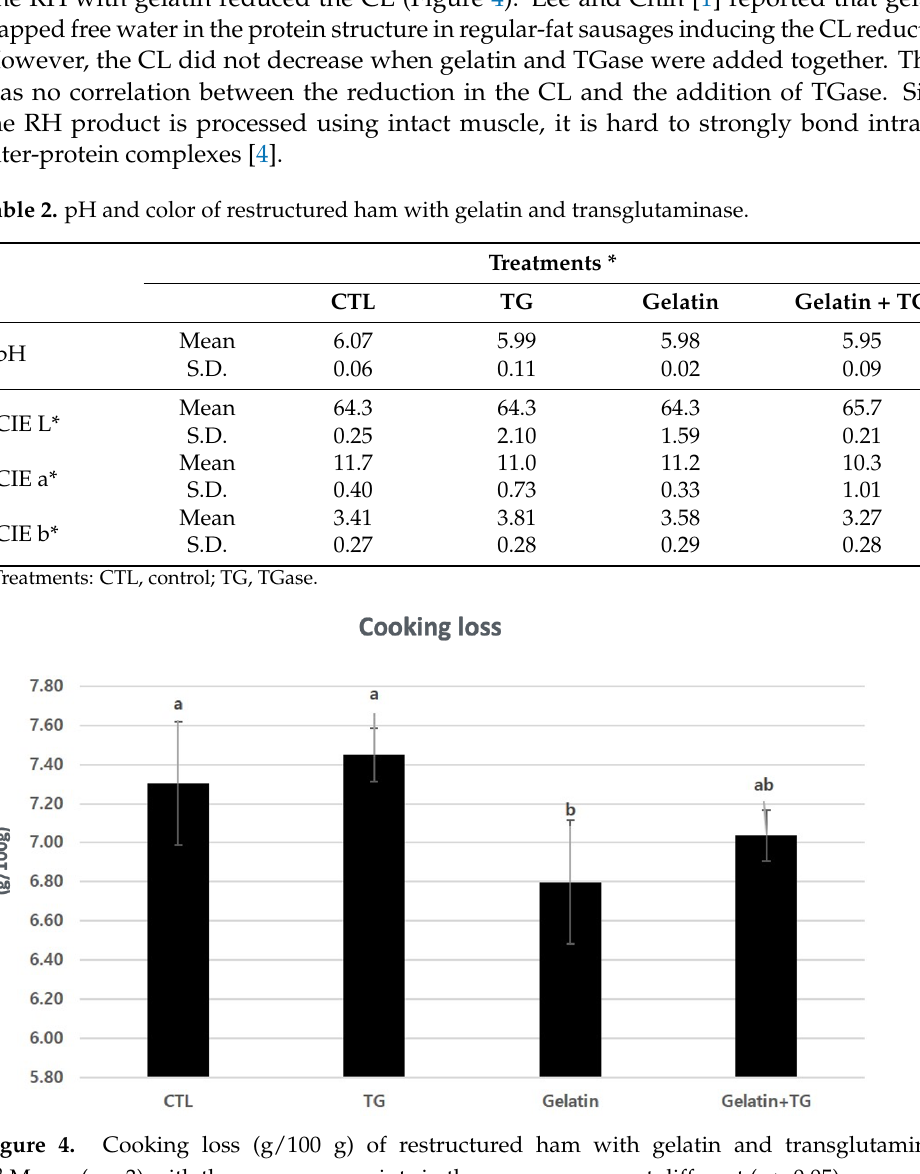
Figure 3. Microstructure of myofibrillar protein mixtures with various additional levels of gelatin and transglutaminase (TGase). ( a ) Control. ( b ) Gelatin 0.5 g/100 g. ( c ) Gelatin 1.0 g/100 g. ( d ) Gelatin 1.5 g/100 g. ( e ) Control with TGase. ( f ) Gelatin 0.5 g/100 g with TGase. ( g ) Gelatin 1.0 g/100 g with TGase,. ( h ) Gelatin 1.5 g/100 g with TGase.